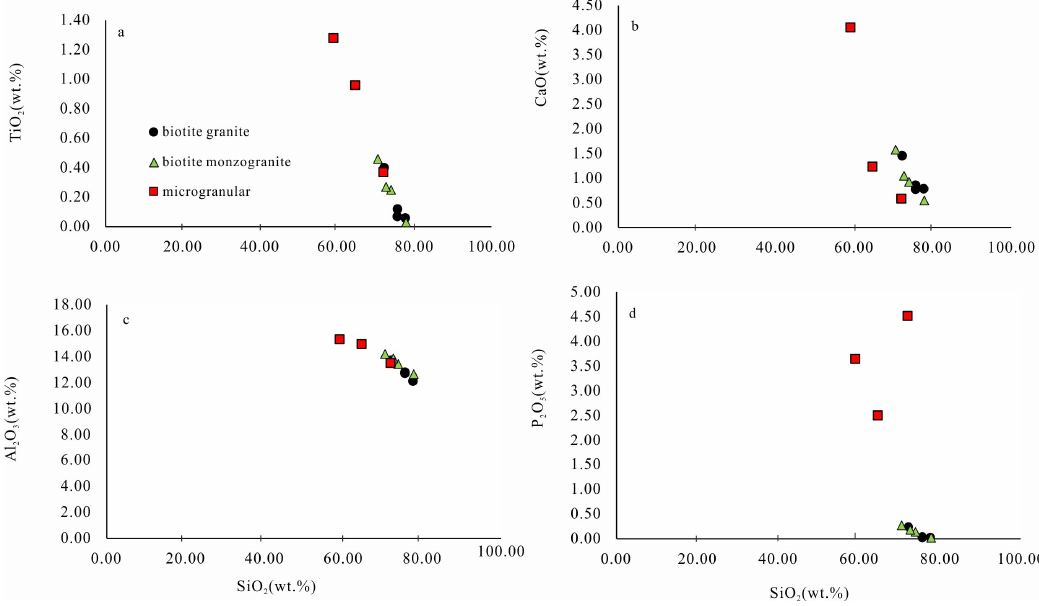
Figure 7 . Harker diagrams showing a variation of selected major oxides (e.g., TiO 2 ( a ), CaO ( b ), Al 2 O3 ( c ), P 2 O 5 ( d )) versus SiO 2 in the Xitian intrusion.